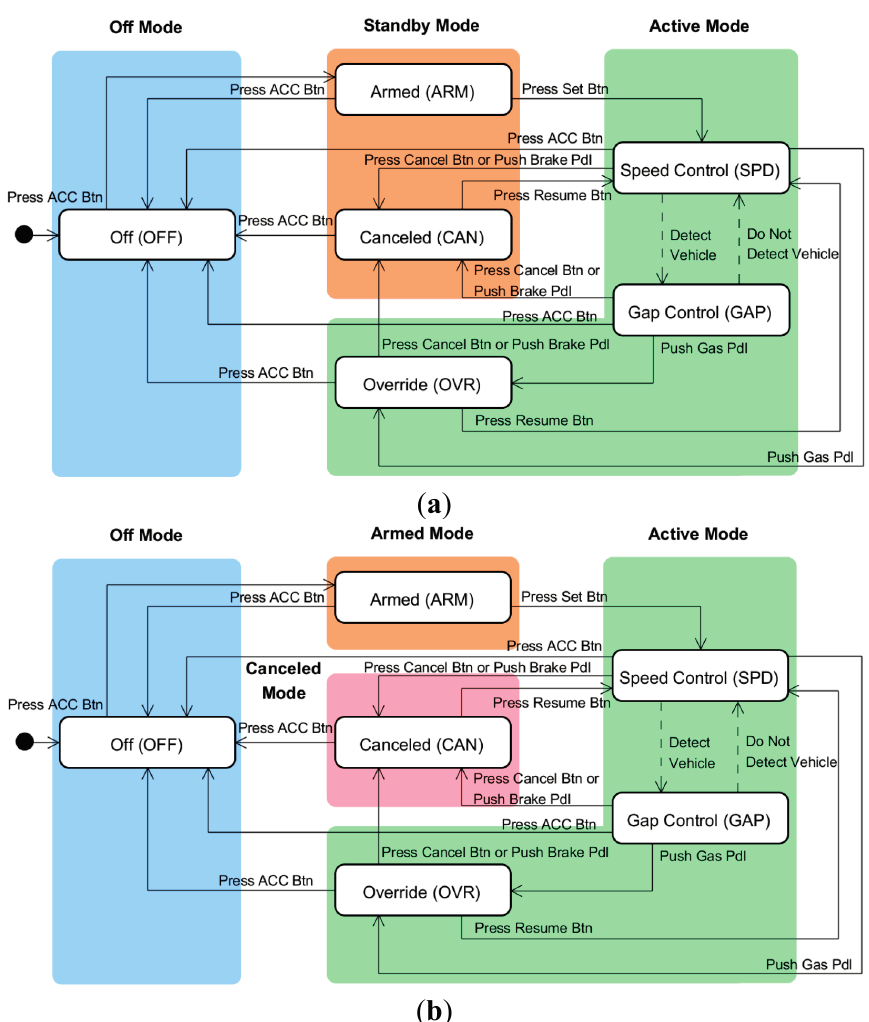
Figure 4. Typical traditional ACC interface models: ( a ) three-mode interface model [17] (by permission of the Korean Society of Mechanical Engineers); and ( b ) four-mode interface